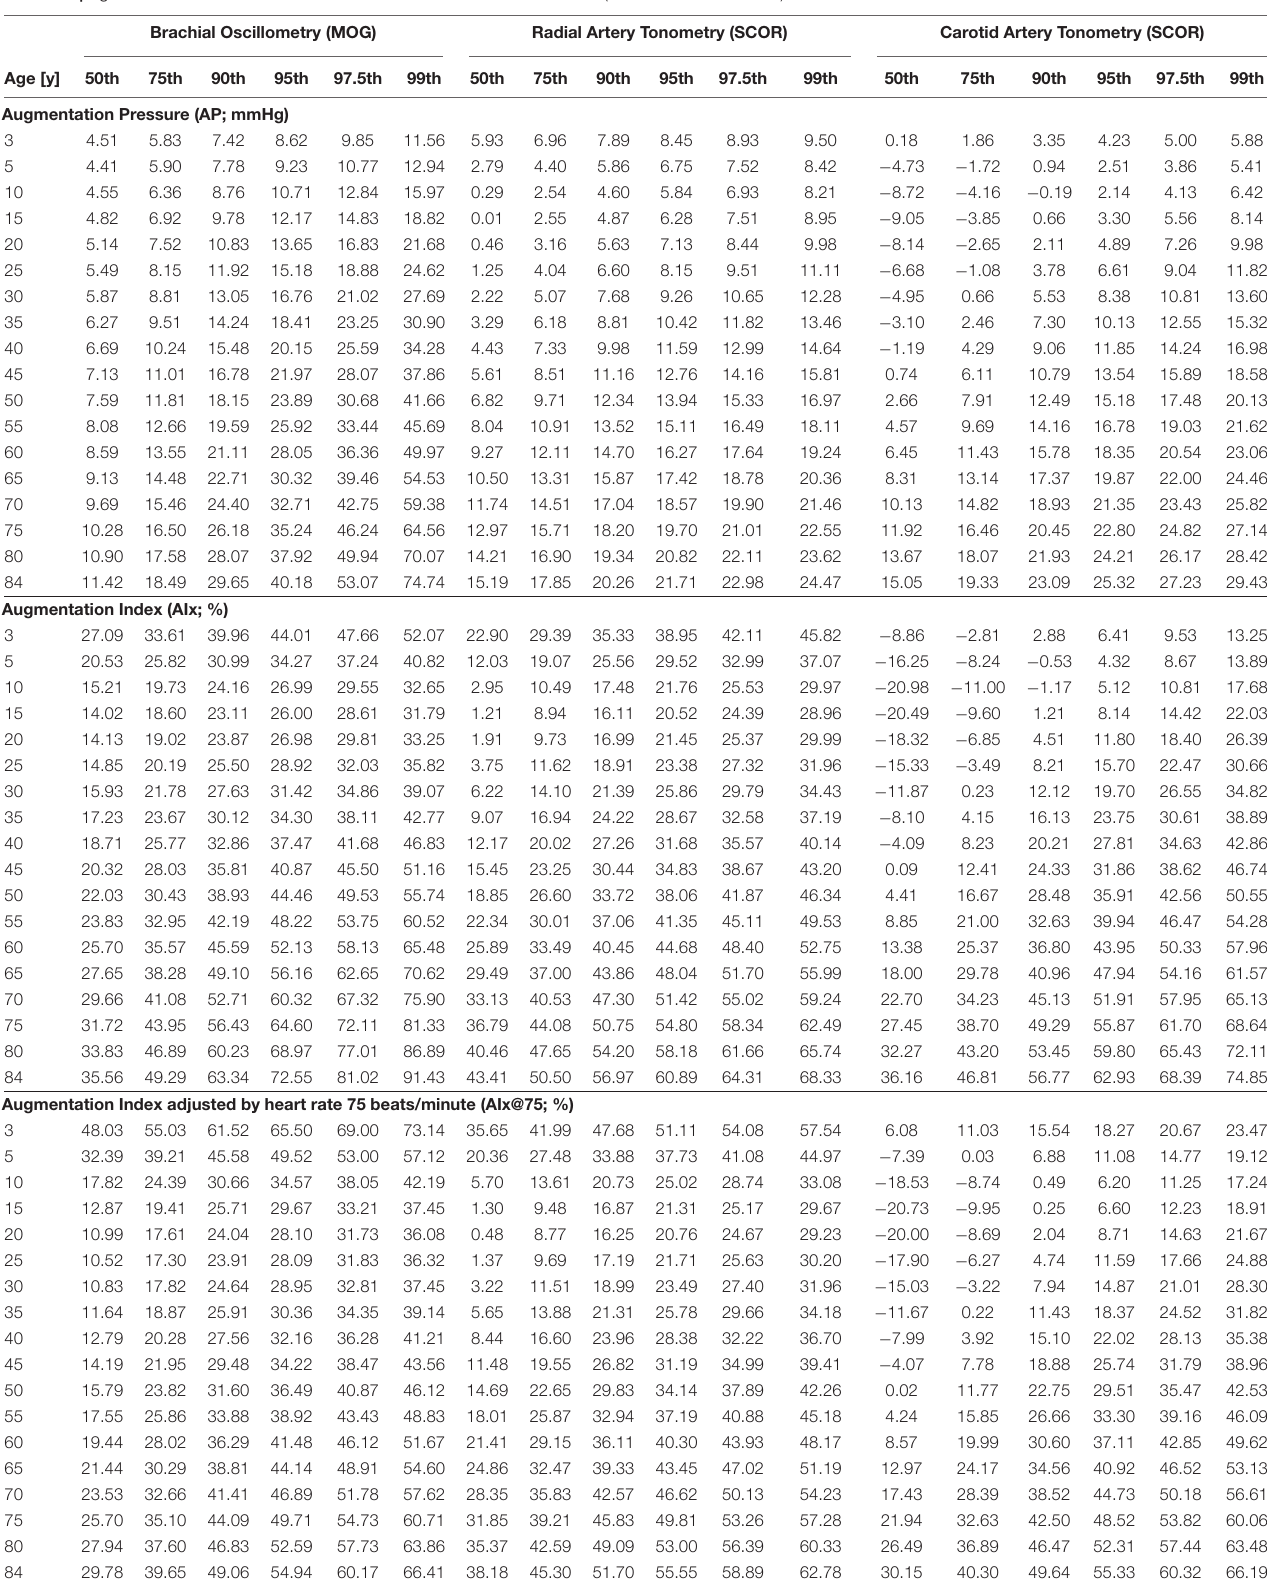
TABLE 4 | Age-related reference intervals for central waveform-derived indexes (All: Females and Males). Brachial Oscillometry (MOG) Radial Artery Tonometry (SCOR) Carotid Artery Tonometry